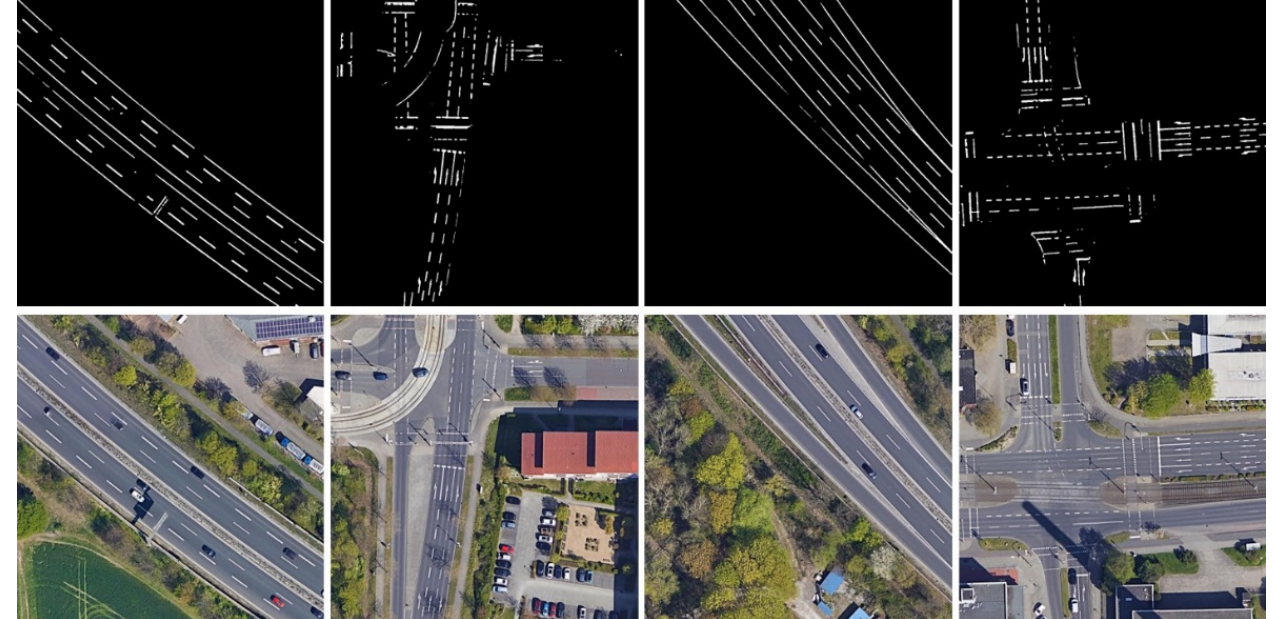
Figure 9. Road marking output from segmentation model in the study area.